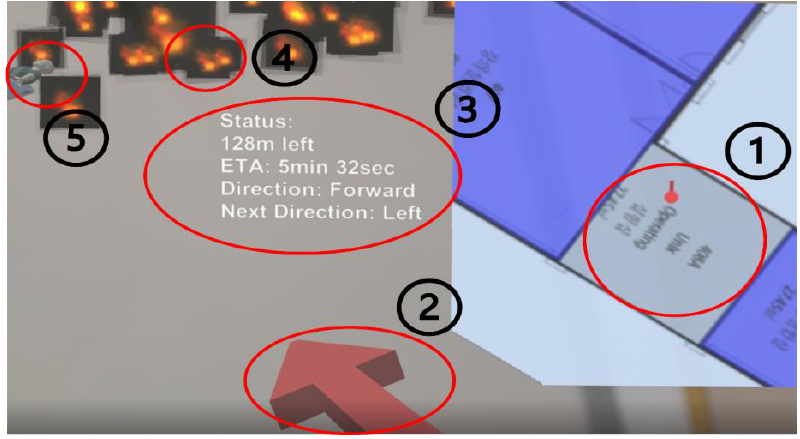
Figure 12. System functions: ① : user position, ② navigation function, ③ status window, ④ virtual disaster site, and ⑤ victim location.